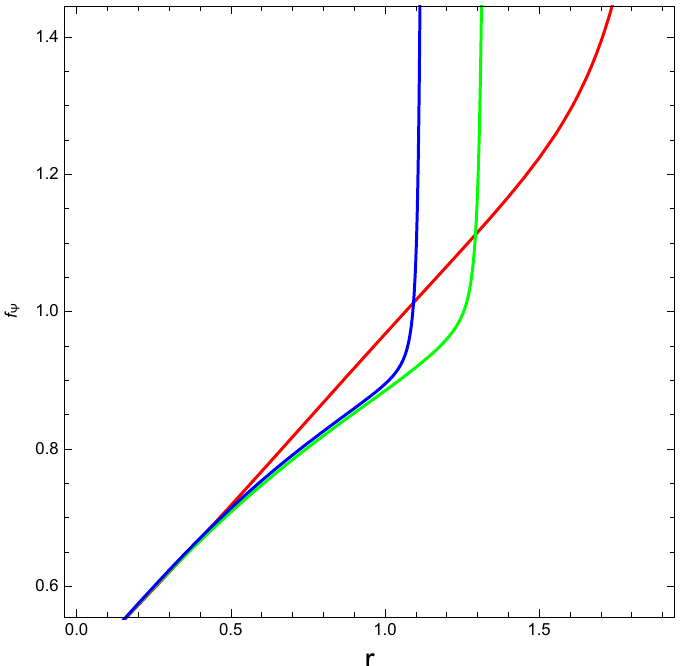
Figure 6. Solution of f ( R ( r )) for R adopted as a linear function of radius. The evolution of Equation (8) under f ( R ( r )) gravity is provided. We have fixed the values of a 0 , a 1 , a 2 , K , and C 1 . The red, green, and blue lines correspond to small perturbations of λ 0 , Ψ 0 , η 1 , η 2 , and η 3 , respectively. In Figures 2, 4 and 6 note that the f ( R ) gravity for Equation (8) has an ascending pattern with respect to r . We obtain different ascending patterns for R being quadratic, exponential, and linear functions of radius. Though, for the quadratic function and linear function, the pattern of the graph is similar. This shows that f ( R ) gravity keeps increasing for larger values of the